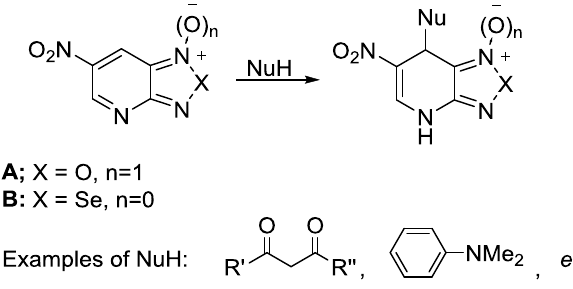
Scheme 1. Reactions of condensed nitropyridines with nucleophiles.